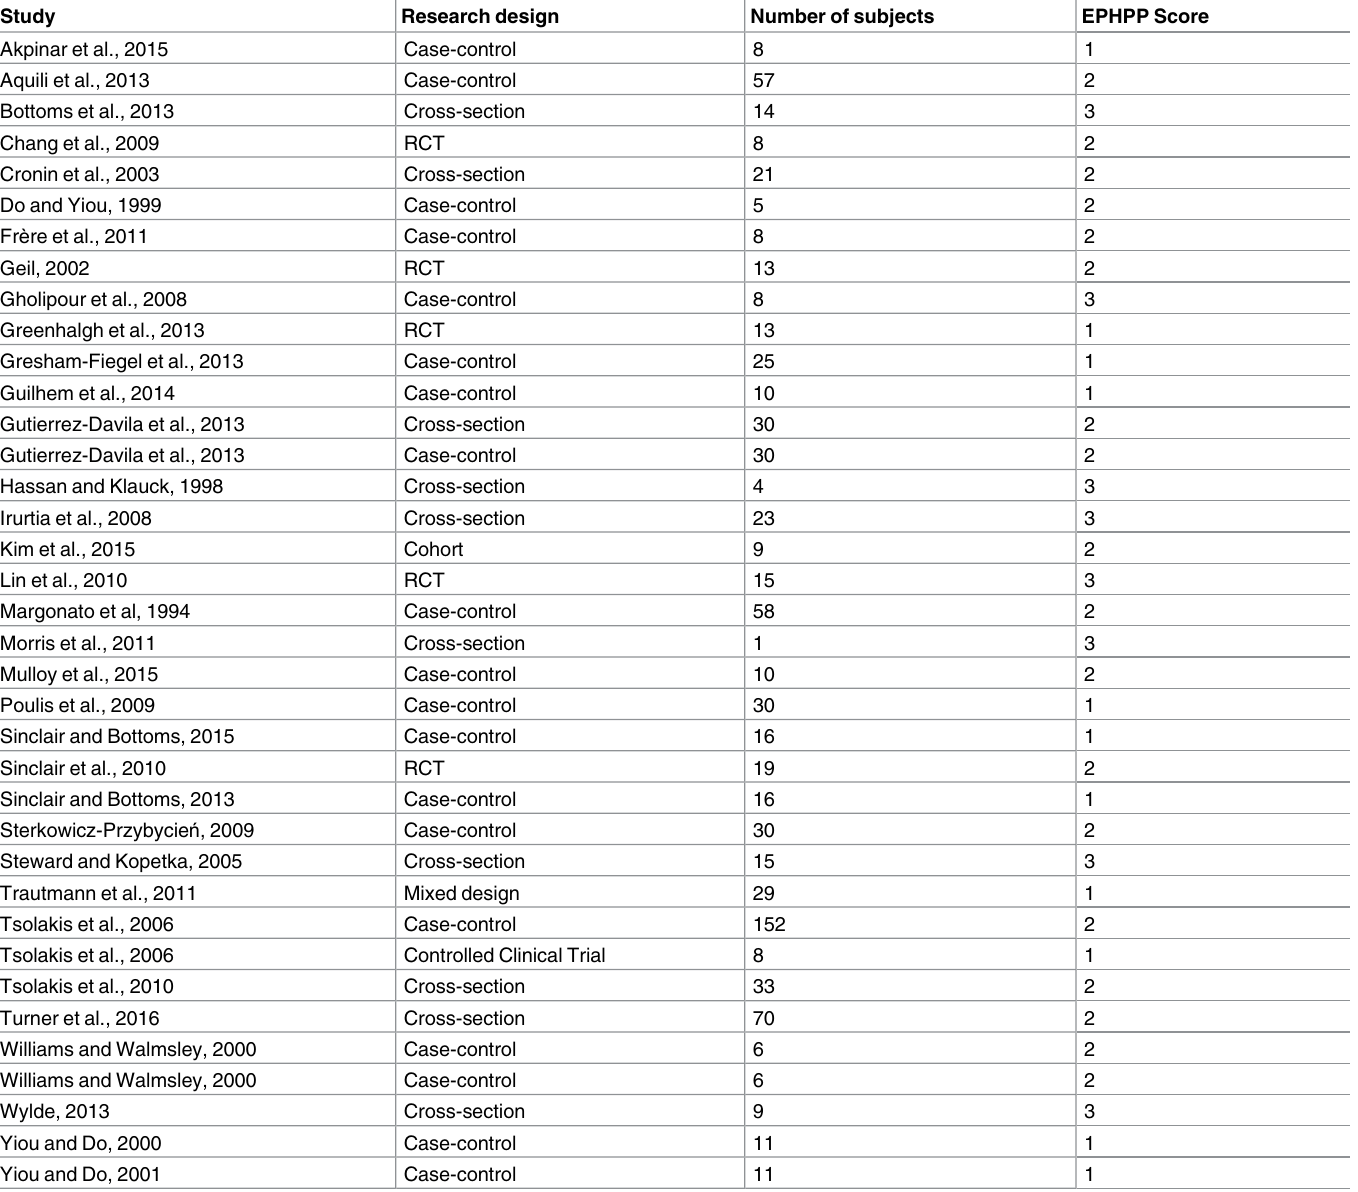
Table 3. EPHPP score for the included